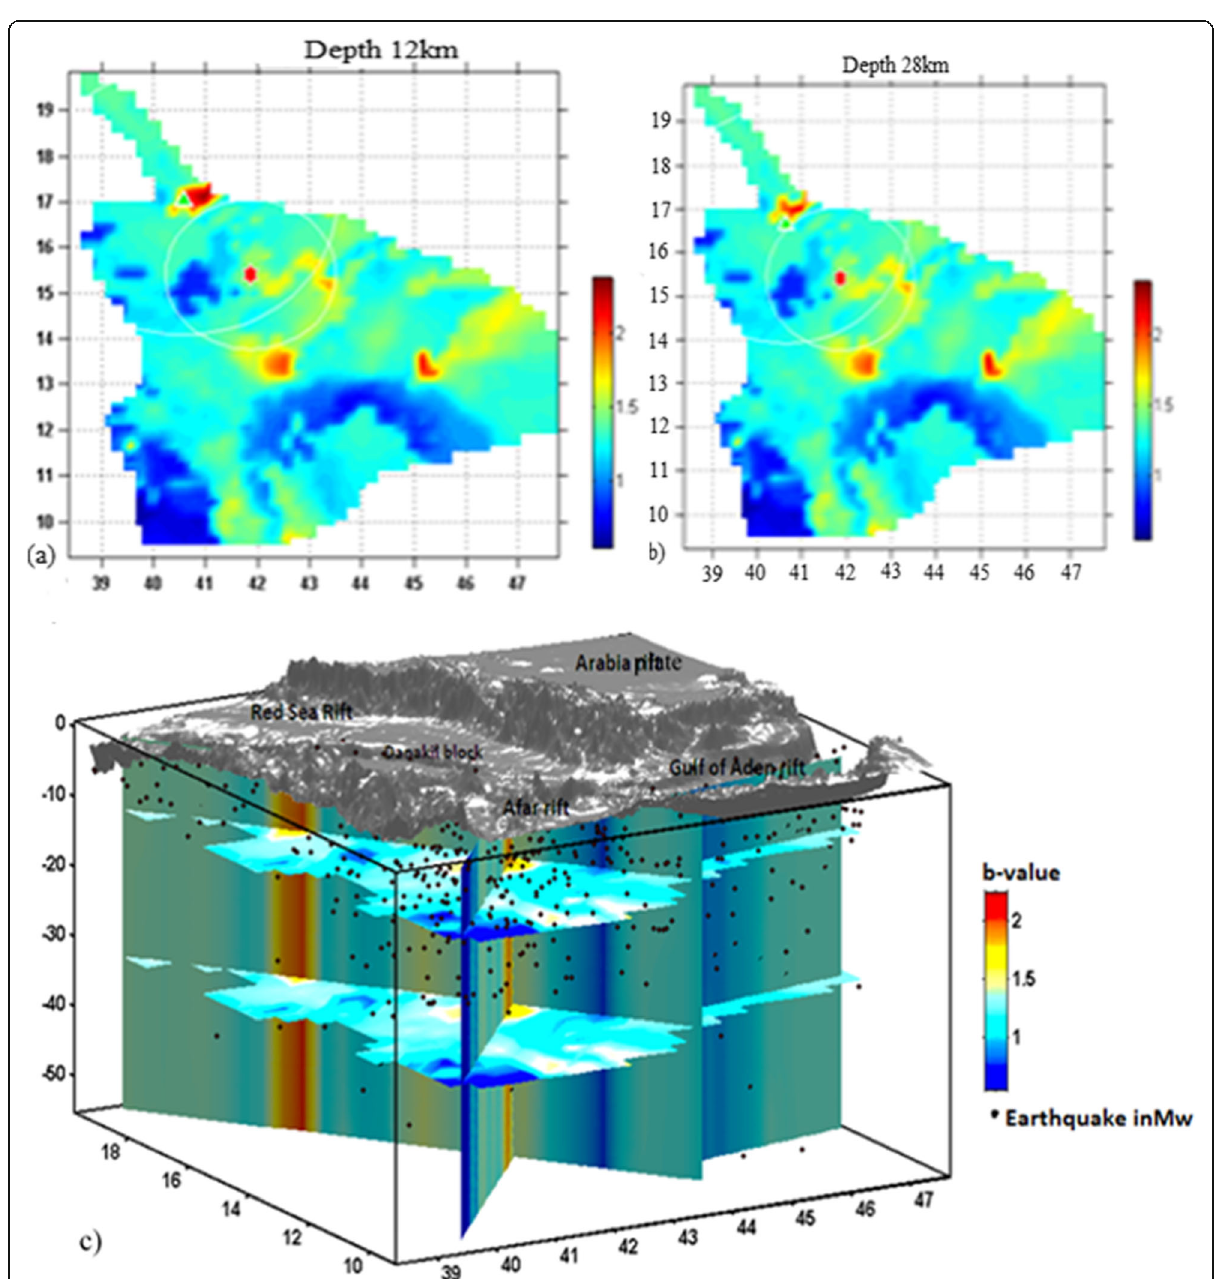
Fig. 7 Depth slices of b-value for Afar Rifts (Including Red Sea and Gulf of Aden);at depth of ( a ) 12 km ( b ) 28kM ( c ) 3D map of b-values throughout time depth plot of